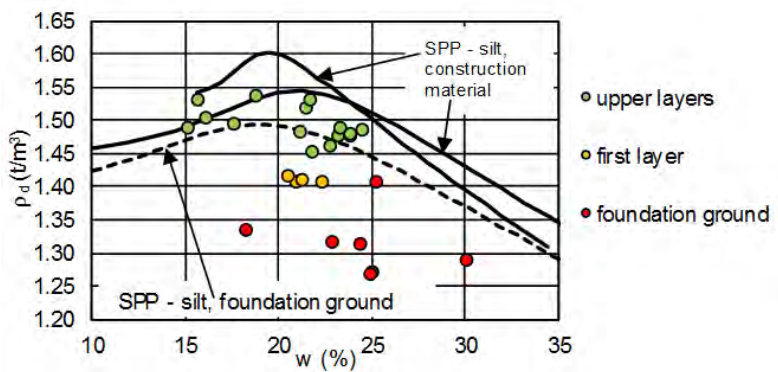
Figure 11. Comparison of standard Proctor test curve (SPP) and dry density achieved during trial embankment compaction.